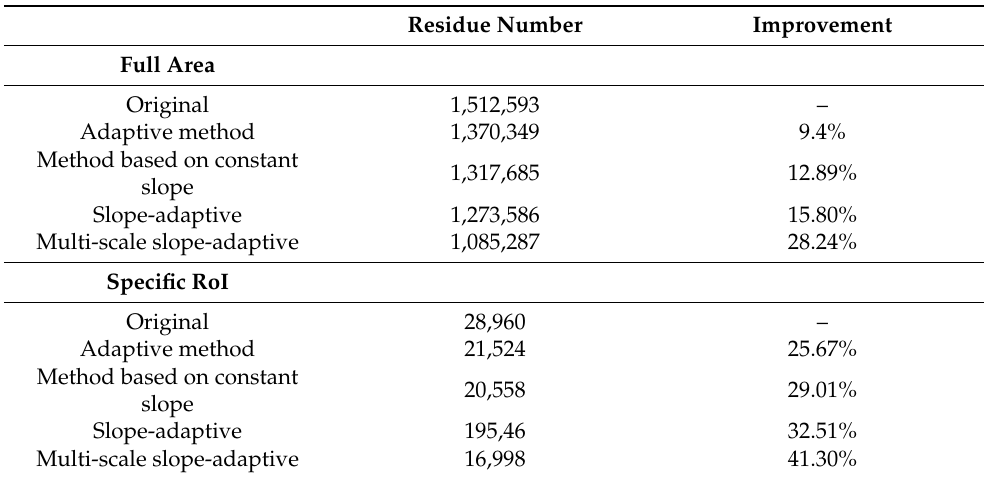
Table 2. Performance analysis of the different range-filtering methods in the full processed area and the specific RoI shown in Figure